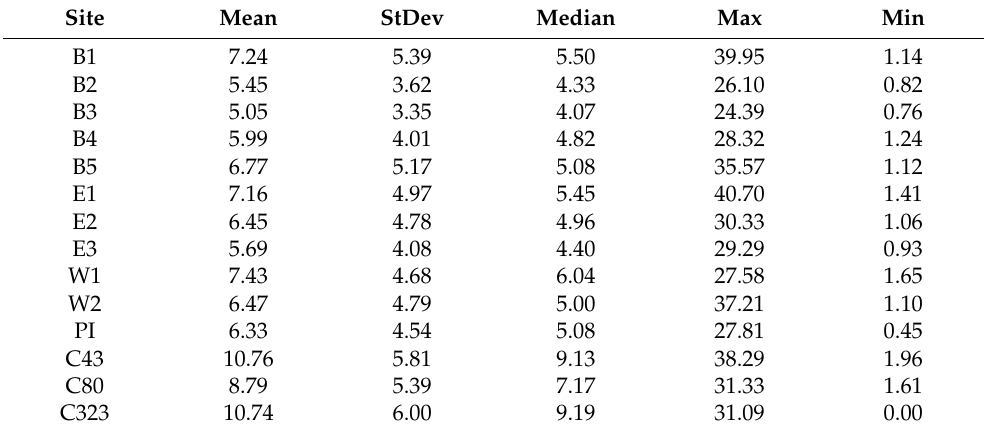
Table 4. Descriptive statistics for 24 h PM 2.5 concentrations ( µ g/m 3 ) in the studied